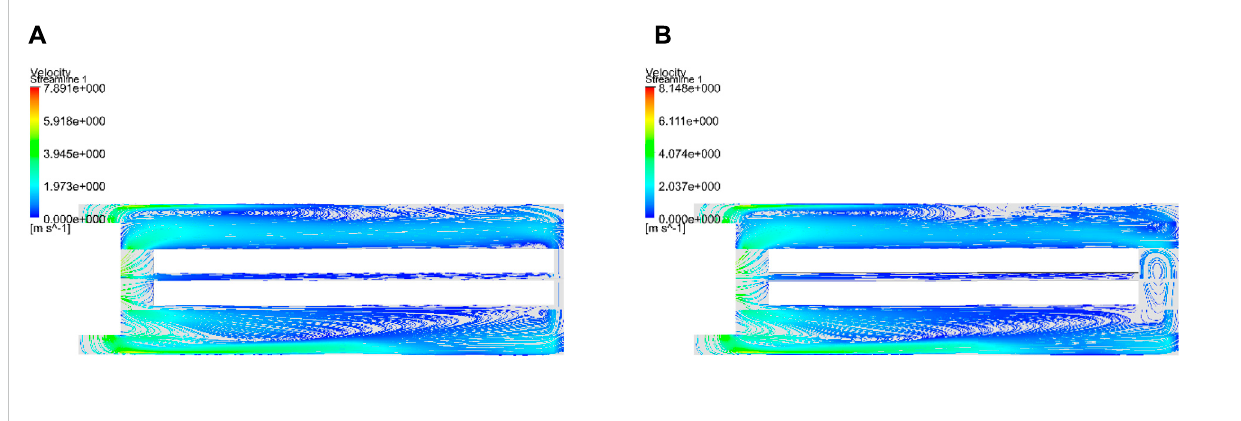
battery region at z = − 0.3 m. In addition, the position of sample Point 2 on Plane 1 is shown in the top left corner of the fi gure, while